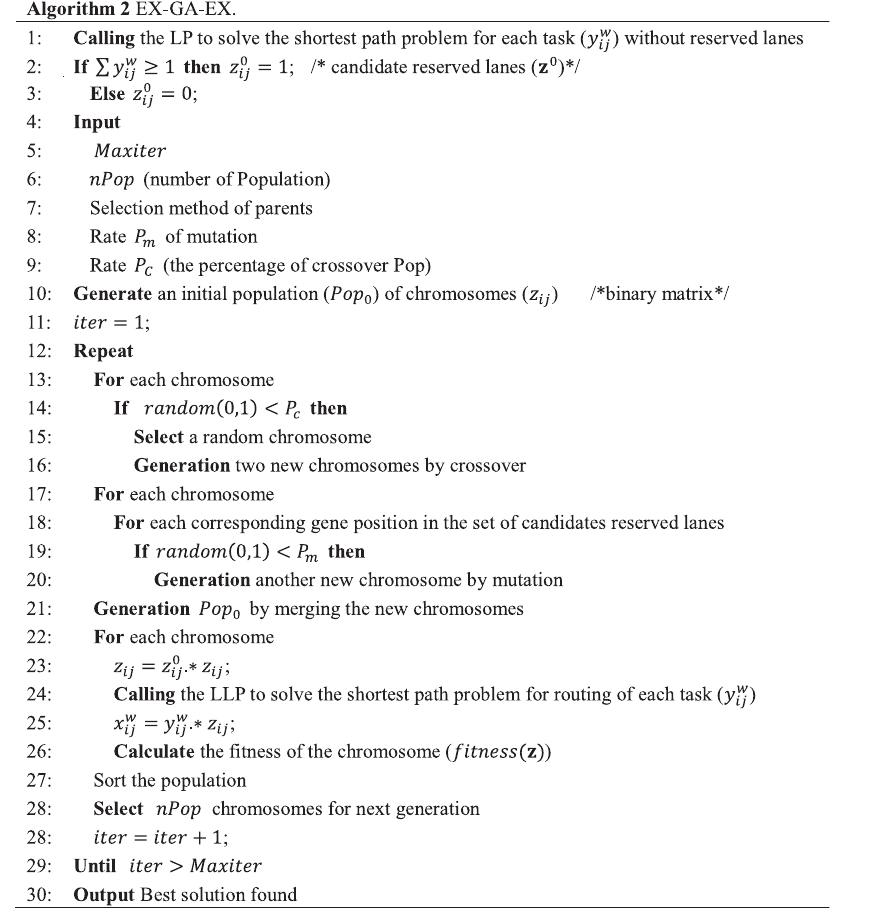
Figure 4: Pseudocode of EX-GA-EX for BHLRP.